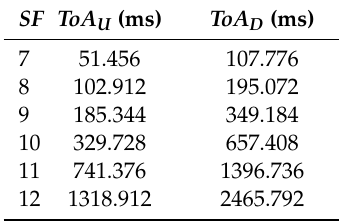
Table 6. Time-on-Air of each uplink and downlink message in the scenario with up to 312 mapped devices, for SF varying from 7 to 12. SF : Spreading Factor; ToA U : Uplink ToA; ToA D : Downlink ToA. SF ToA U